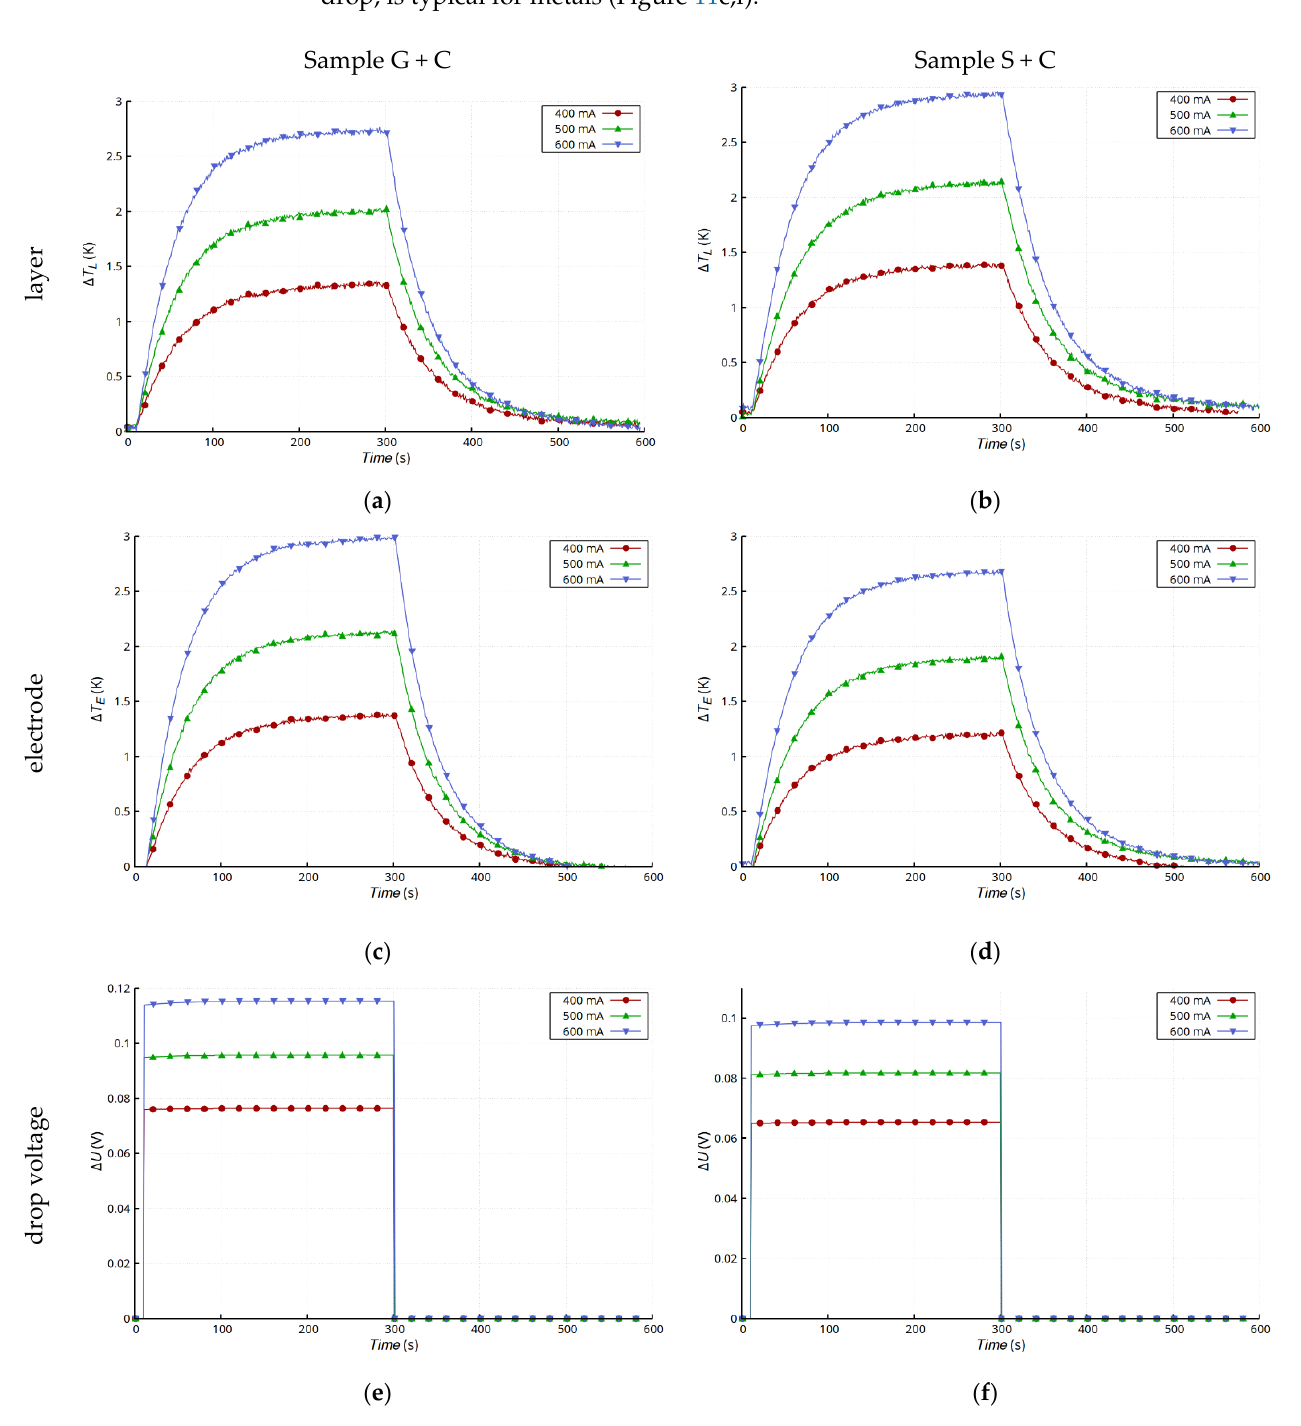
Figure 11. Comparison of results for glued electrodes (G + C) and soldered electrodes (S + C) on Al 2 O 3 substrate: changes in temperature of Ag layer Δ T L (G + C) ( a ) and (S + C) ( b ); changes of temperature in electrode Δ T E (G + C) ( c ) and (S + C) ( d ); and drop voltage on samples Δ U 4W (G + C) ( e ) and (S + C) ( f ).